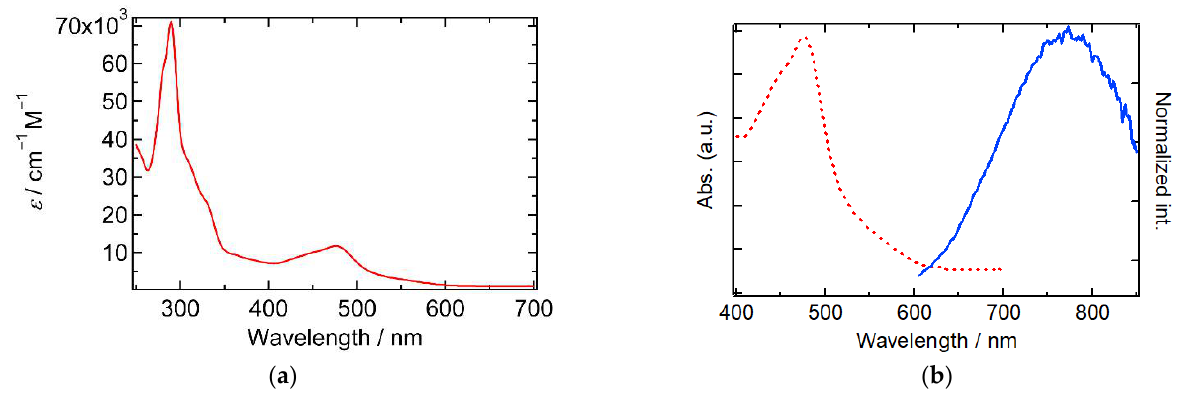
Figure 3. ( a ) UV-Vis absorption spectrum of complex 1 in acetonitrile ( c = 1.0 × 10 − 5 M); ( b ) absorption (red dotted line) and emission (blue solid line) spectra of complex 1 in acetonitrile.